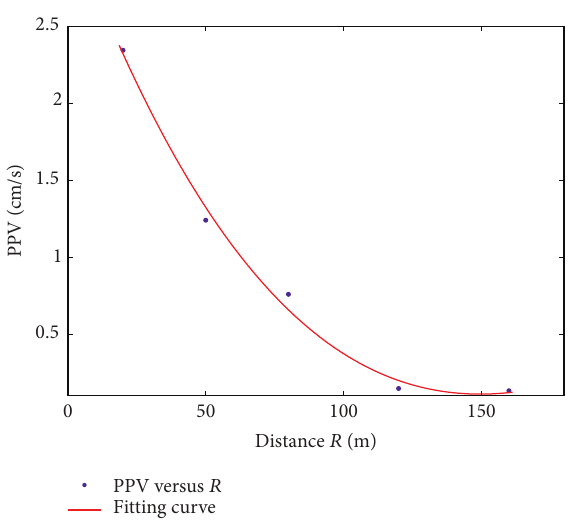
Figure 9: Changing curve of vibration velocity with distance from blasting center.